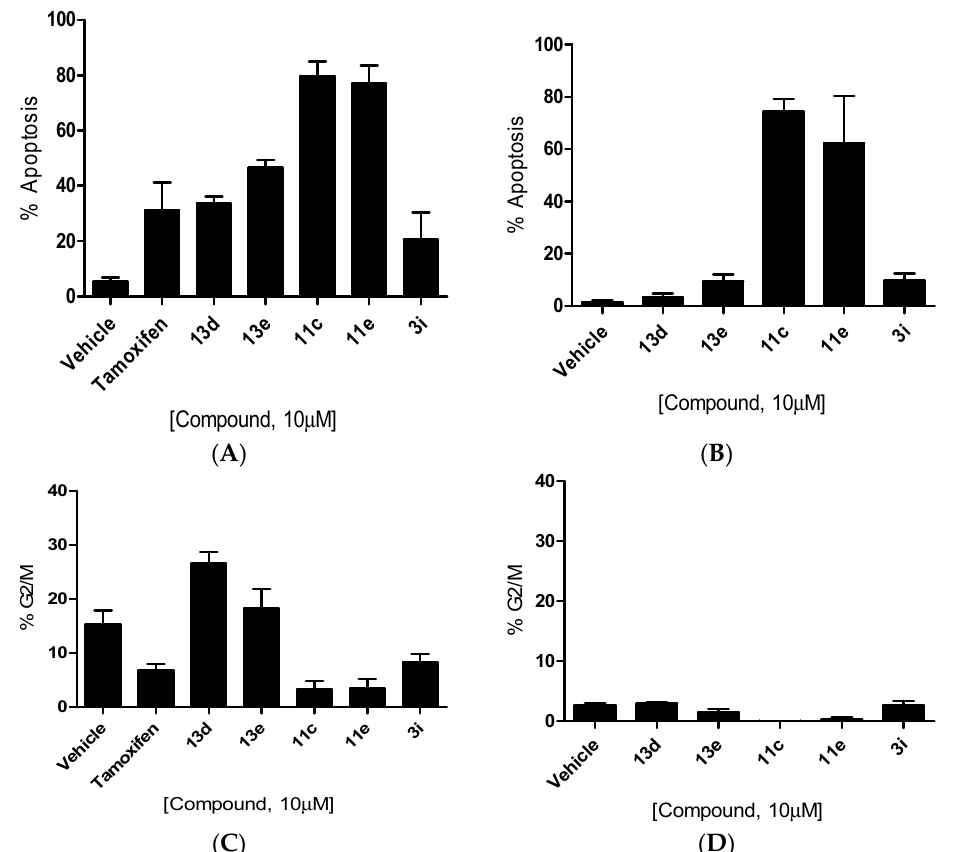
Figure 2. Compounds 3i , 11c , 11e , 13d and 13e potently induce apoptosis in MCF-7 cells, but not healthy PBMCs. Cells were treated for 72 h with a vehicle or the indicated compounds. After the required incubation period, cells were fixed in 1 mL ethanol and 100 μ L PBS and stained with propidium iodide. Cells were subsequently analysed by flow cytometry to determine the percentage of apoptotic ( A ) MCF-7 cells and ( B ) PBMCs and G2/M-arrested ( C ) MCF-7 cells and ( D ) PBMCs. Values represent